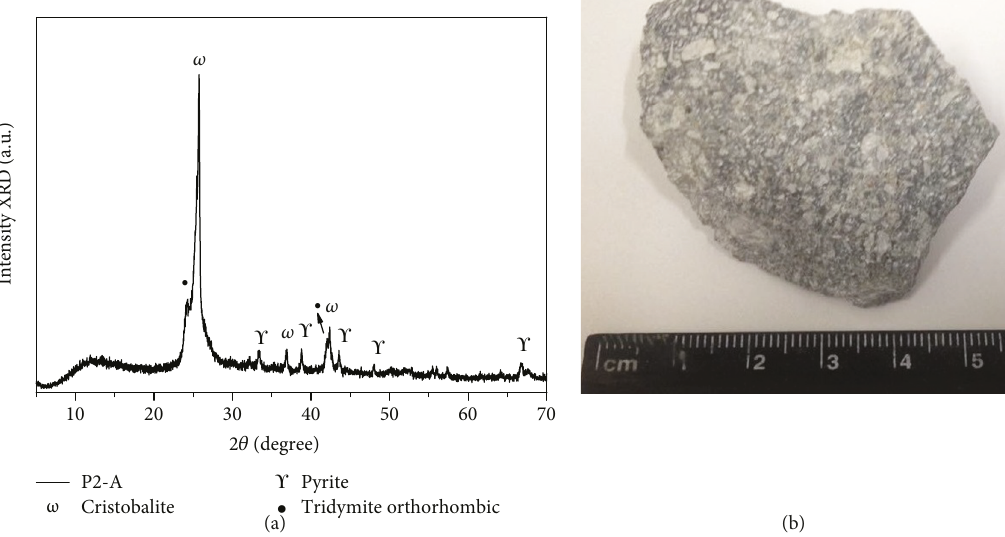
Figure 11: Sample P2-A (a) XRD patterns and (b) rock sample of crystalline tu ff .